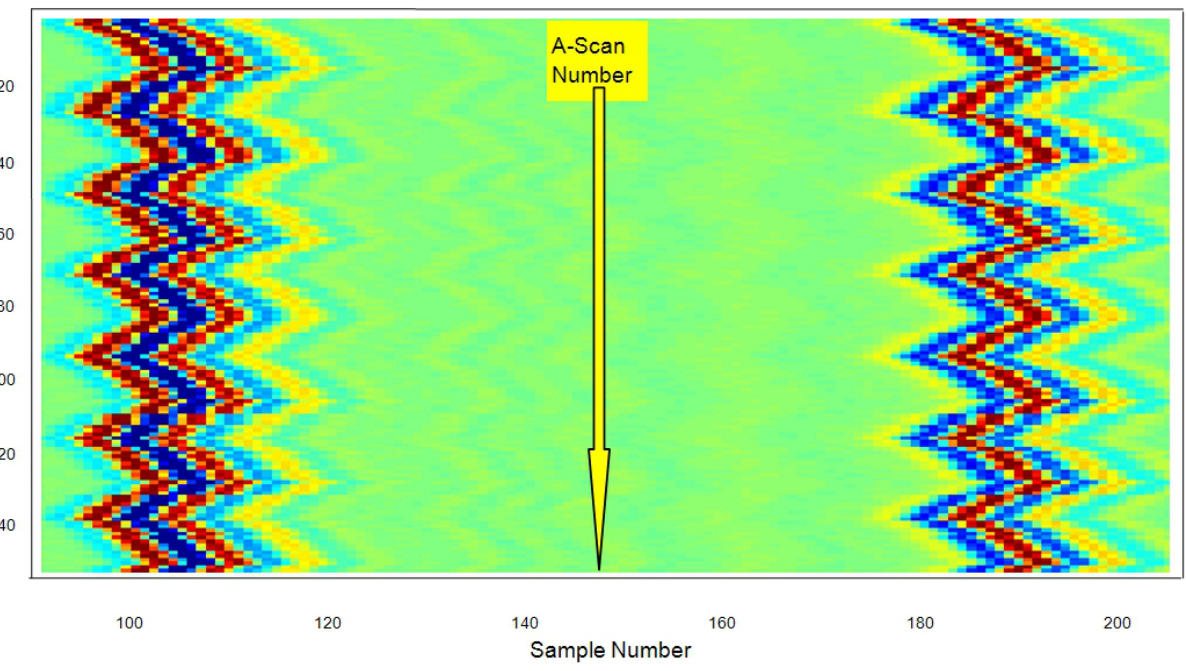
Figure 10. Display in color scale of all 150 echoes from the first tube wall, showing coarse wall